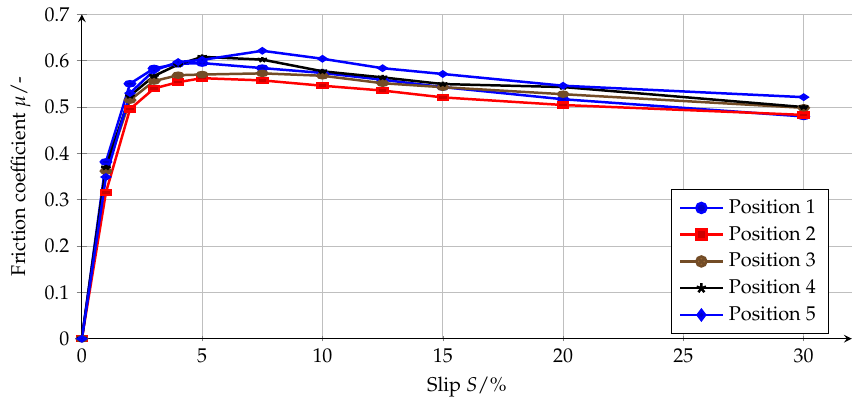
Figure 17. Variation of slip and road position for pattern BB at 140kmh − 1 . The positions are each displaced 20mm relative to each other in the direction of